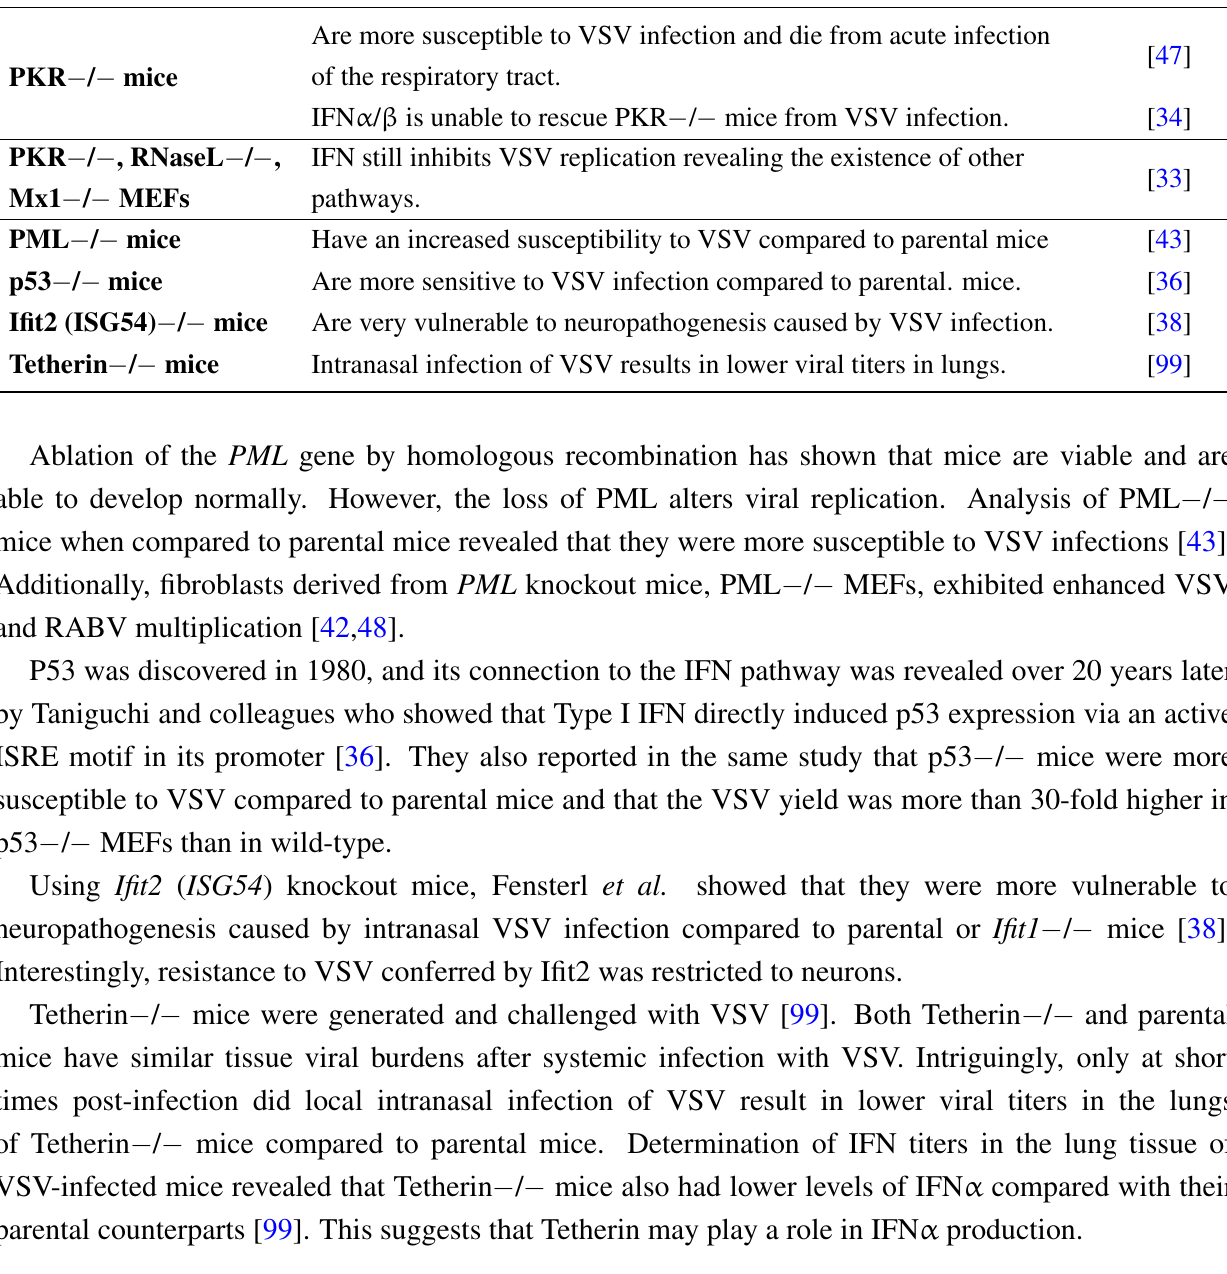
Table 2. Results obtained from VSV-infected knockout mice and their derived cell lines. ISG